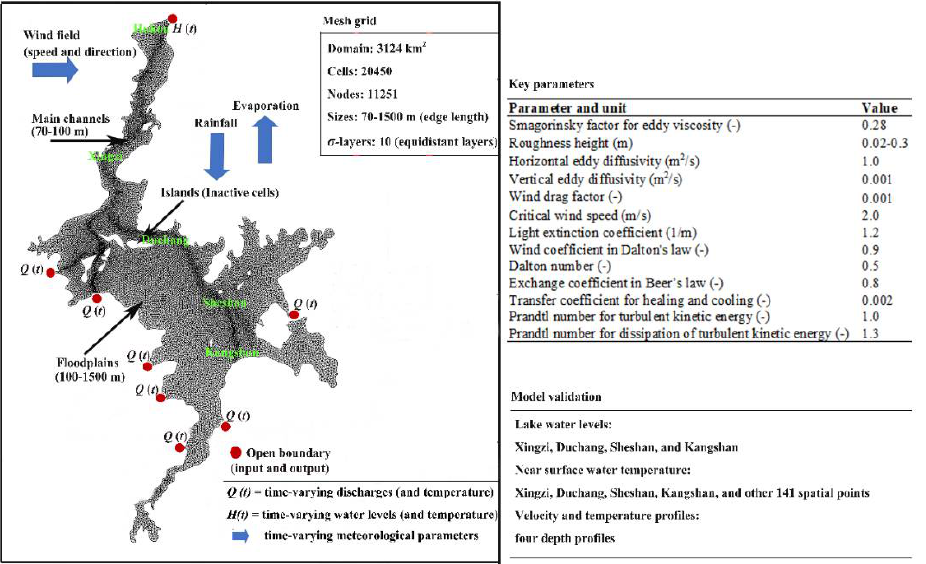
Figure 4. Computational domain, mesh grid, boundary conditions, key parameters, and model validation information for the MIKE 3 model of the Poyang Lake-floodplains, according to Li et al. [17].